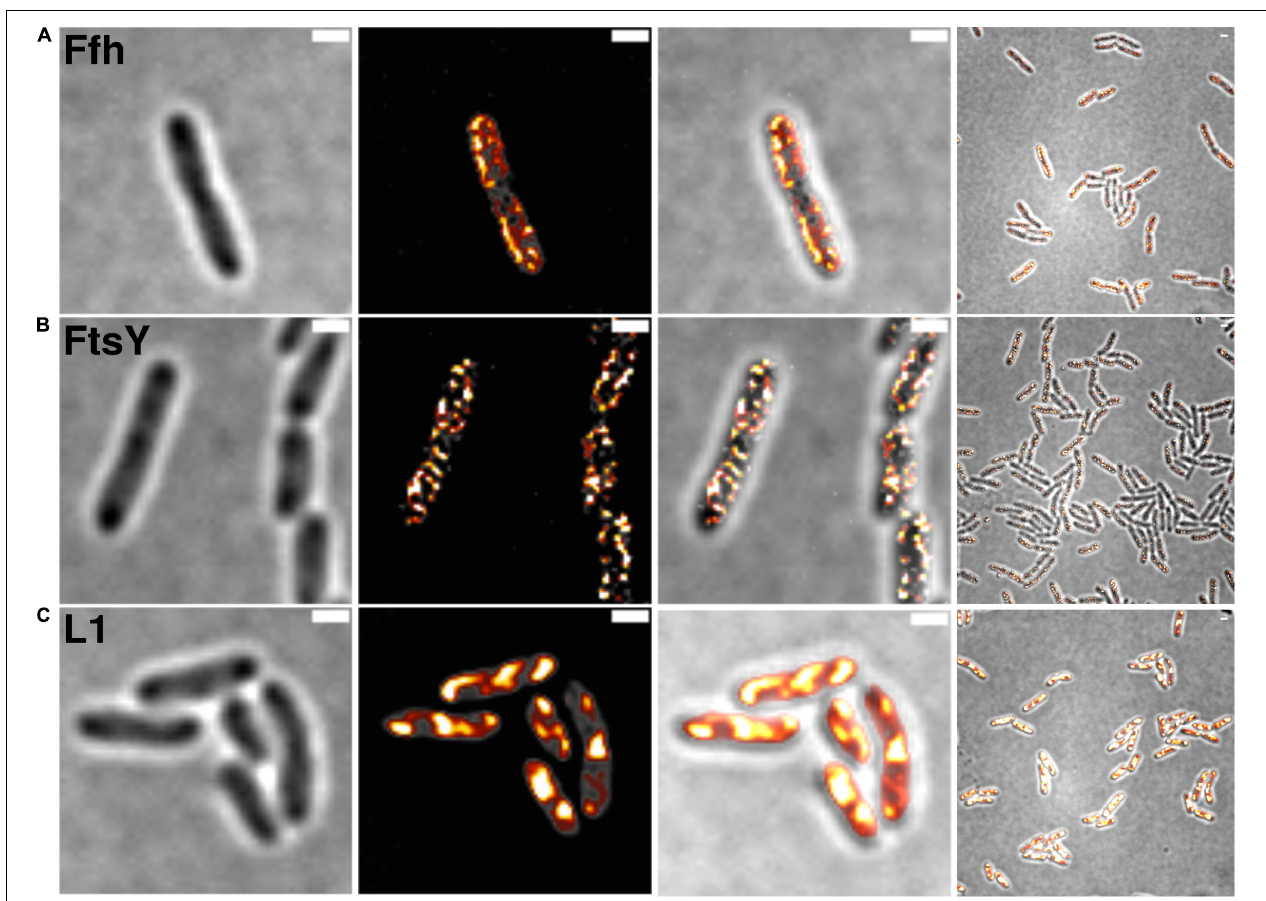
FIGURE 2 | Structured illumination microscopy imaging of SRP interaction partners in S. putrefaciens at mid-exponential phase. (A) Static fractions of Ffh are distinctly located in close proximity to the cell membrane. Z-stack projection shows localization densities of static Ffh particles. Higher particle densities and gradients are indicated by multi-color coding with gray (little signal) to red-shifted (high signal). (B) Static fractions of FtsY also show highest densities close to the cell membrane. (C) Different from Ffh and FtsY, L1 shows distinct subcellular localizations representing nucleoid occlusion with high localization density at pole regions and septum. Z-stack projection shows similar patterns throughout the cells. Proteins are fused to sfGFP and are expressed as sole source of the proteins, at physiological levels. Left panels bright field acquisition, second panels SIM acquisition, third panels color coded SIM gradient, right panels color coded Z-stack projections. Scale bars 1 µ